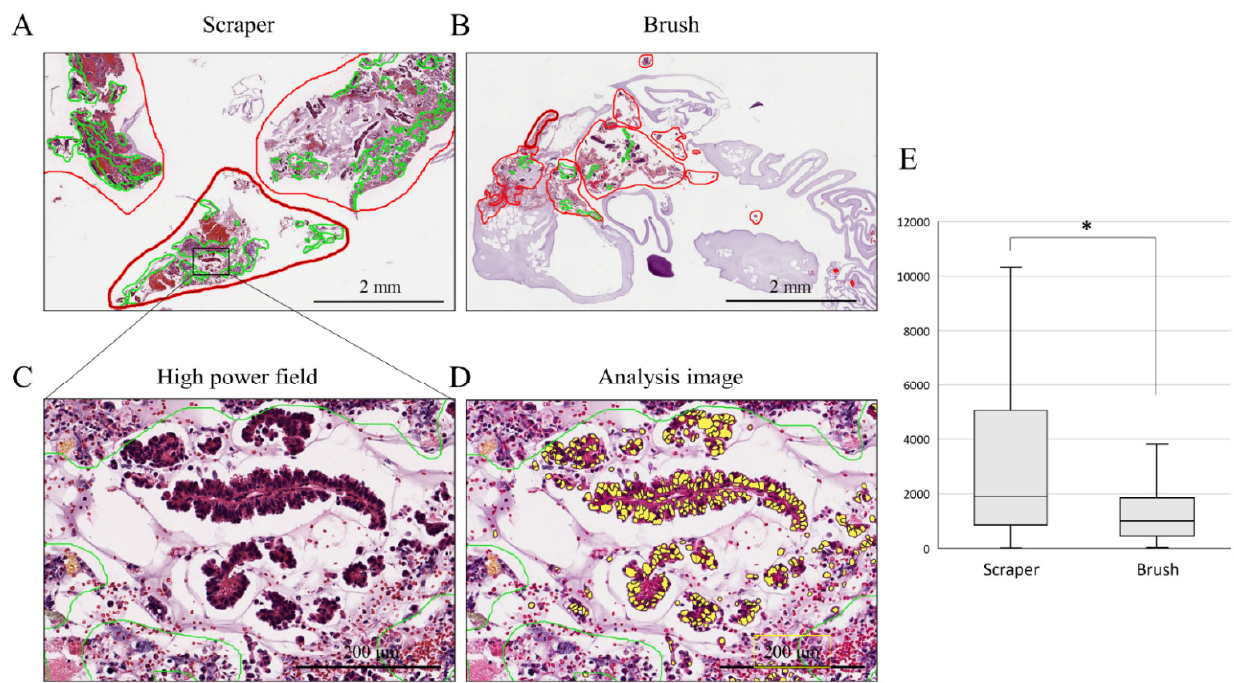
Figure 1. Epithelial cell count analysis on cell block sections. ( A , B ): histological findings of scraper group ( A ) and brush group ( B ) in low-power field. The areas with epithelial components are circled in red. The areas circled by the green line were excluded due to the presence of necrotic tissue and inflammatory cells. ( C , D ): histological findings in high-power field ( C ) and analysis image of Aperio CS2 ( D ). Yellow-colored nuclei; only the nuclei of the epithelial component were measured. ( E ): comparison of the median numbers of cells obtained by each device; *, p < 0.05.